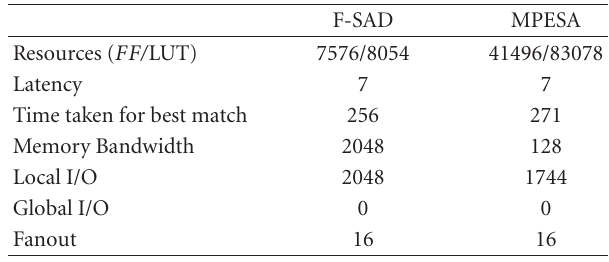
Table 7: Evaluation of proposed architecture against the fixed size SAD architecture. Resource count is expressed in terms of Flip- Flops (FF) and Look-Up Tables (LUT).